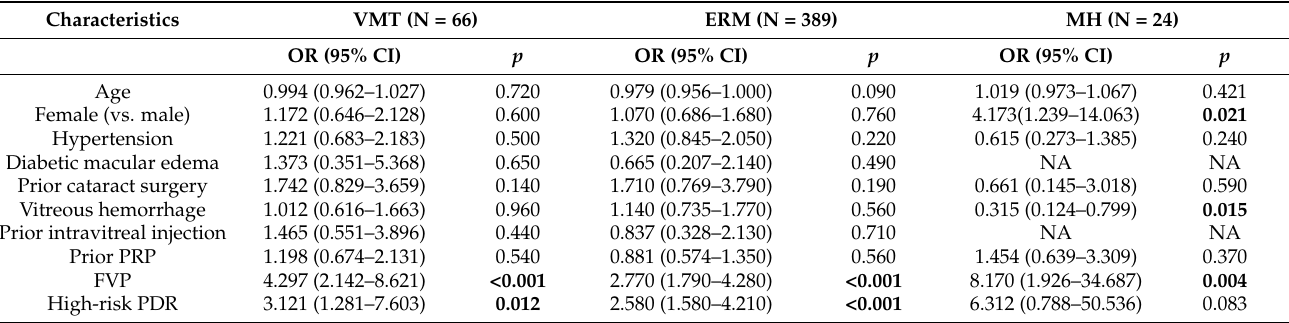
Table 3. Univariate analyses of the baseline factors associated with vitreomacular interface disorders in proliferative diabetic